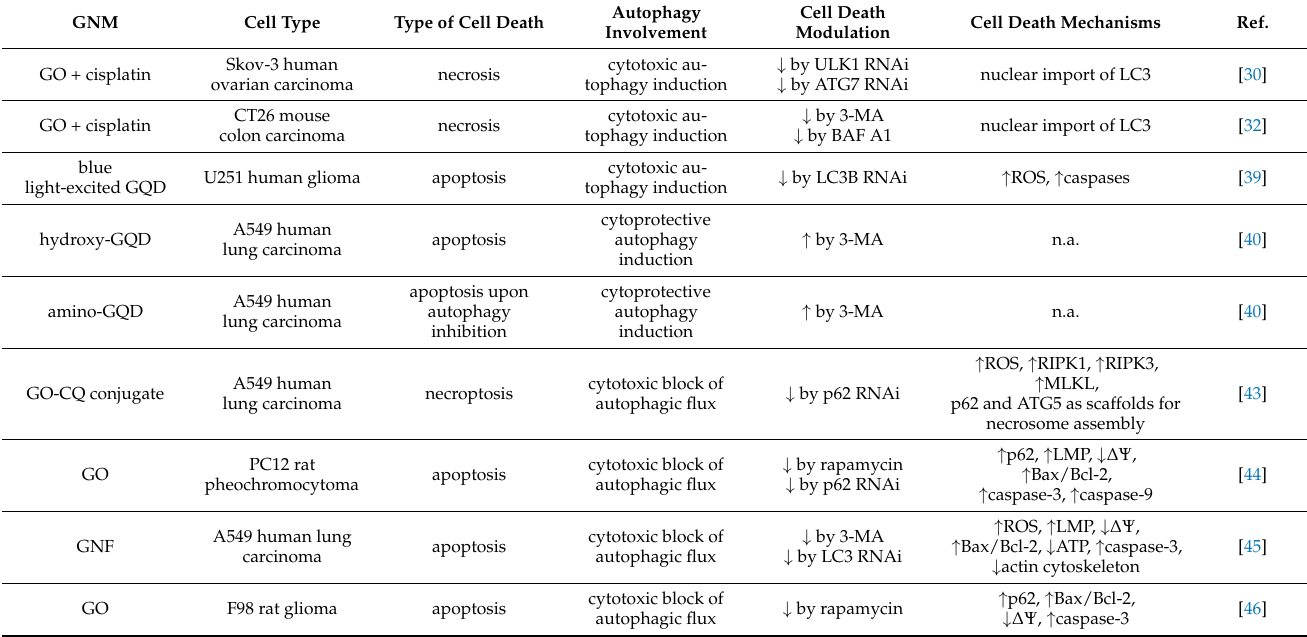
Table 2. The role of autophagy modulation in GNM-induced cancer cell